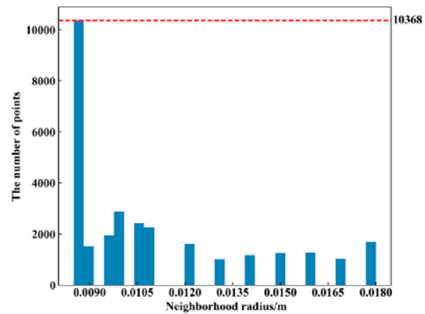
Figure 20. Adaptive optimal neighborhood radius distribution of point cloud in the shelf scene.